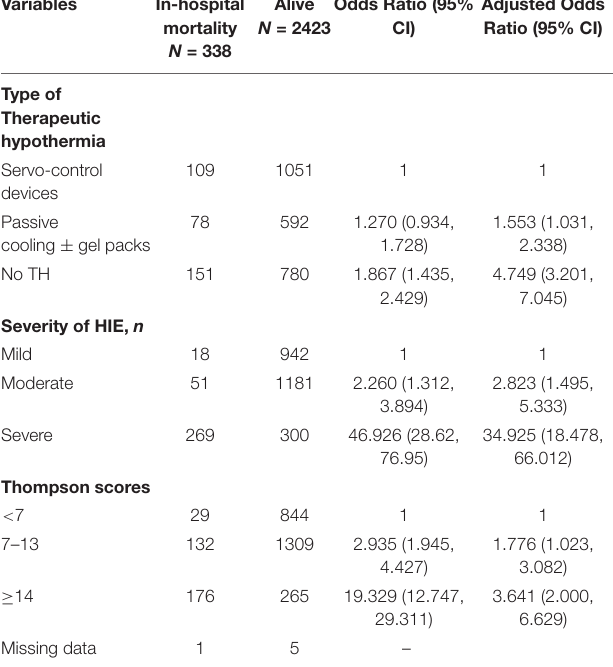
TABLE 5 | Simple and multiple logistic regression analyses of potential risk factors associated with in-hospital mortality in all HIE neonates in the Malaysian National Neonatal Registry (MNNR),